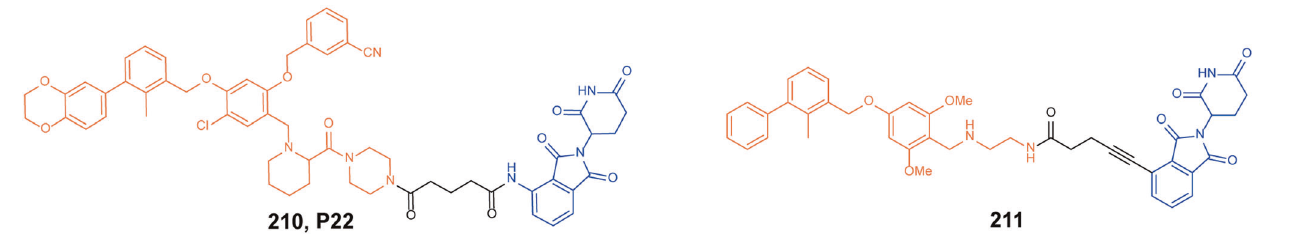
Fig. 63 The representative PROTACs targeting PD-L1